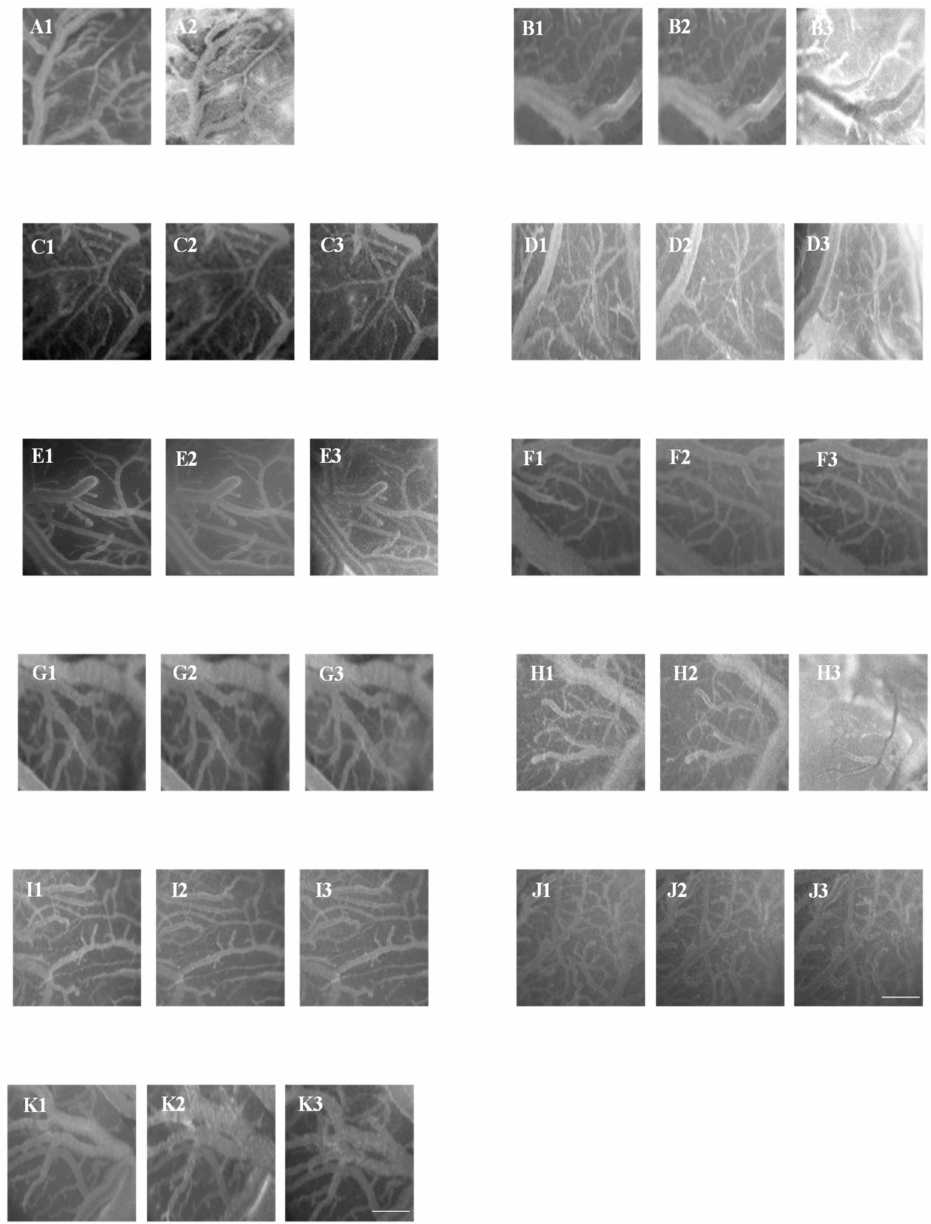
Figure 4. Images of pial microvascular networks obtained by computerized dedicated program. In ( A1 ) the pial microvas- cular network is reported in baseline conditions ( A2 ) after 60 min of reperfusion in a hypoperfused rat (Hc group), where it is possible to observe the increase in microvascular leakage by the marked change in the color of interstitium (from black to white). The pial network under baseline conditions ( B1 ) 10 min after the local application of AngII ( B2 ) and at the end of reperfusion ( B3 ) in a rat belonging to the AngII-L group, where after local application of Ang II there was no change in microvascular permeability, while it significantly increased after reperfusion. ( C1 ) reports the pial network under baseline conditions ( C2 ) 10 min after the local application of Ang 1-7 and in ( C3 ) after 60 min of reperfusion of a rat belonging to the Ang1-7-L group. No permeability increase was detected 10 min after Ang 1-7 administration or at the end of reperfusion. The pial network under baseline conditions ( D1 ) 10 min after the local application of candesartan cilexetil ( D2 ) and at the end of reperfusion ( D3 ), where it is possible to evaluate a significant microvascular leakage as observed in the Hc group. ( E1 ) reports the pial vasculature under baseline conditions ( E2 ) 10 min after the local application of candesartan cilexetil plus Ang II locally applied and ( E3 ) at the end of reperfusion of a rat of C-AngII-L group. No significant leakage of fluorescent dextran was detected compared with Hc group. ( F1 ) reports the pial microcirculation under baseline conditions( F2 ) 10 min after the jugular vein infusion of candesartan cilexetil and ( F3 ) at the end of reperfusion in a rat of C-J group. Image of the